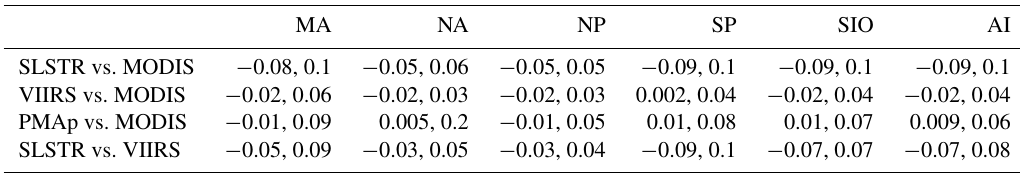
Table 3. Quantification of AOD differences between instruments over the ocean regional domains (defined in Table 2) for the DJF period. Each cell gives the MD followed by the